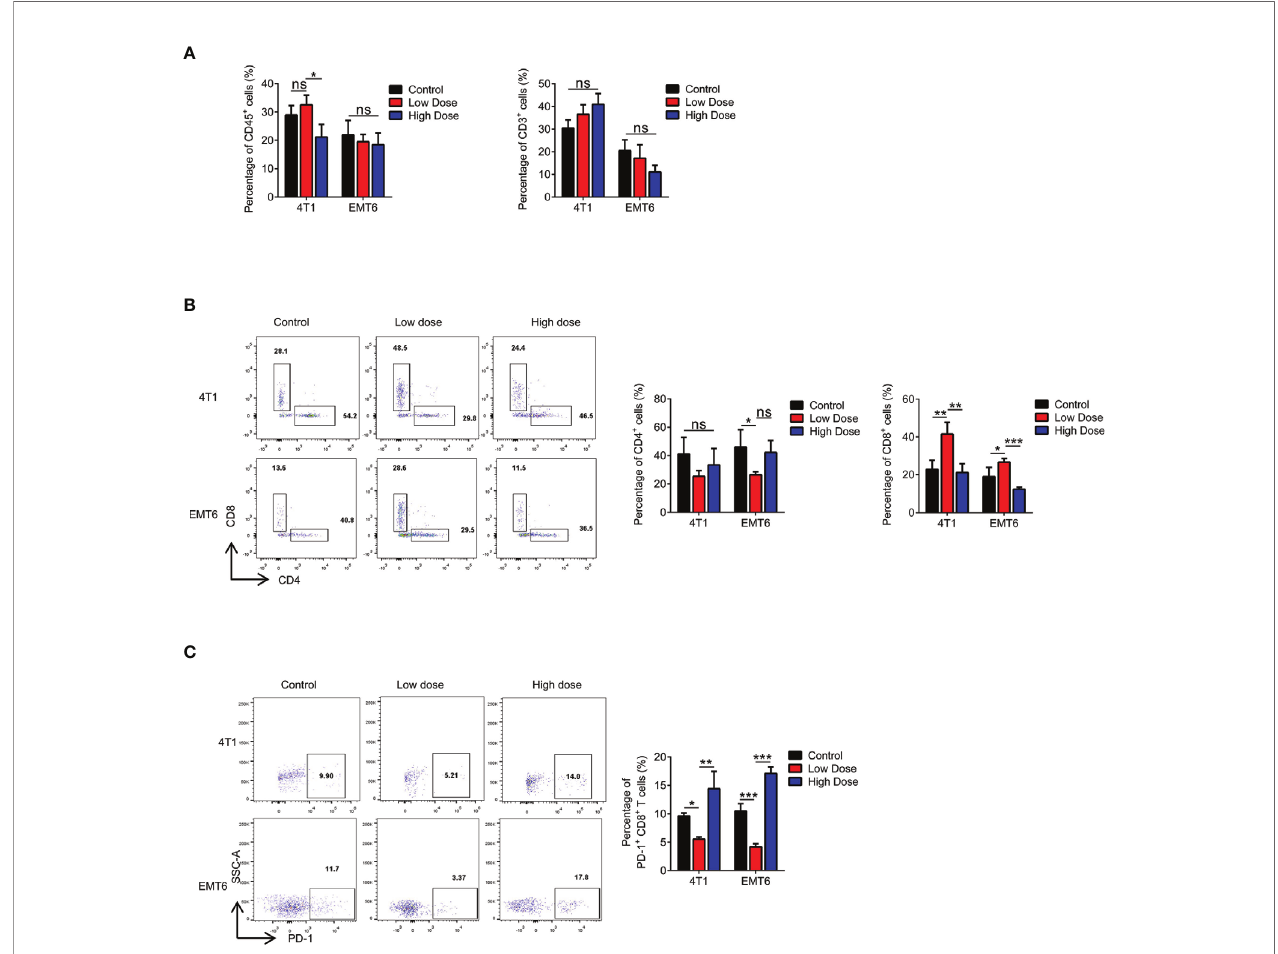
FIGURE 5 | High-dose VEGFR2-TKI therapy exhausts CD8 + T cells in the tumor. (A) Flow cytometry analysis of immune cells (CD45 + ) and T cells (CD45 + CD3 + ) in the tumor after VEGFR2-TKI therapy. (B) Frequency of CD4 + T cells (CD45 + CD3 + CD4 + ) and CD8 + T cells (CD45 + CD3 + CD8 + ) in the tumor. (C) Frequency of PD-1 expression on CD8 + T cells in the tumor after VEGFR2-TKI therapy. Data are presented as the means ± SD from one representative experiment. Similar results were obtained from three independent experiments, n=4 mice each group, unless indicated otherwise. Statistical analysis was performed by two-tailed unpaired Student ’ s t test, ns, not signi fi cant, *p < 0.05, **p < 0.01, and ***p < 0.001. See also Supplementary Figure S5